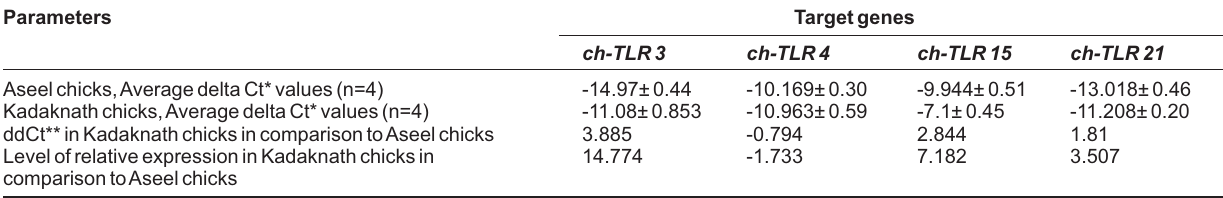
Table-2. Constitutive expression of ch-TLR 3, ch-TLR 4, ch-TLR 15 and ch-TLR 21 in PBMCs from Aseel and Kadaknath chicks